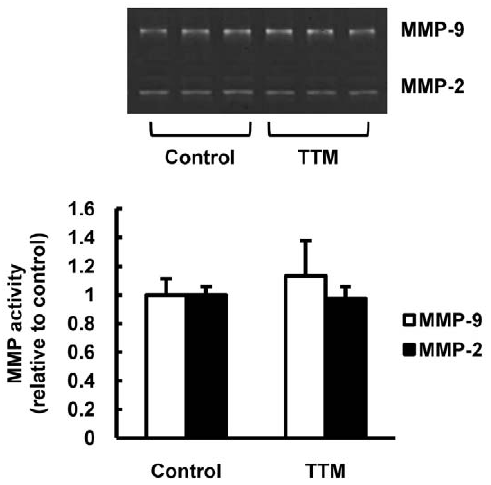
Figure 2. Expression of the activity of MMP-2 and MMP-9 in copper depleted rat lungs. Representative gelatin zymogram of protein extracts from control and TTM treated rat lungs. The bar graph shows the relative density of MMP-2 and MMP-9 bands of TTM treated rat lungs compared to that of control bands. Data are expressed as mean 6 SE